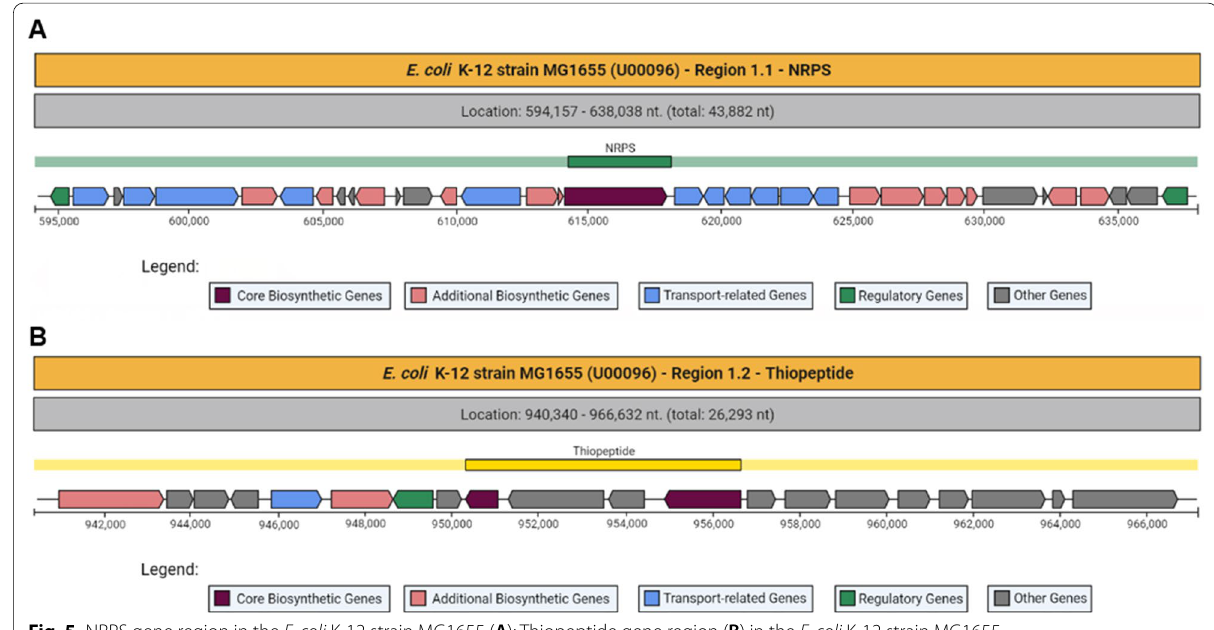
Fig. 5 NRPS gene region in the E. coli K-12 strain MG1655 ( A ); Thiopeptide gene region ( B ) in the E. coli K-12 strain MG1655